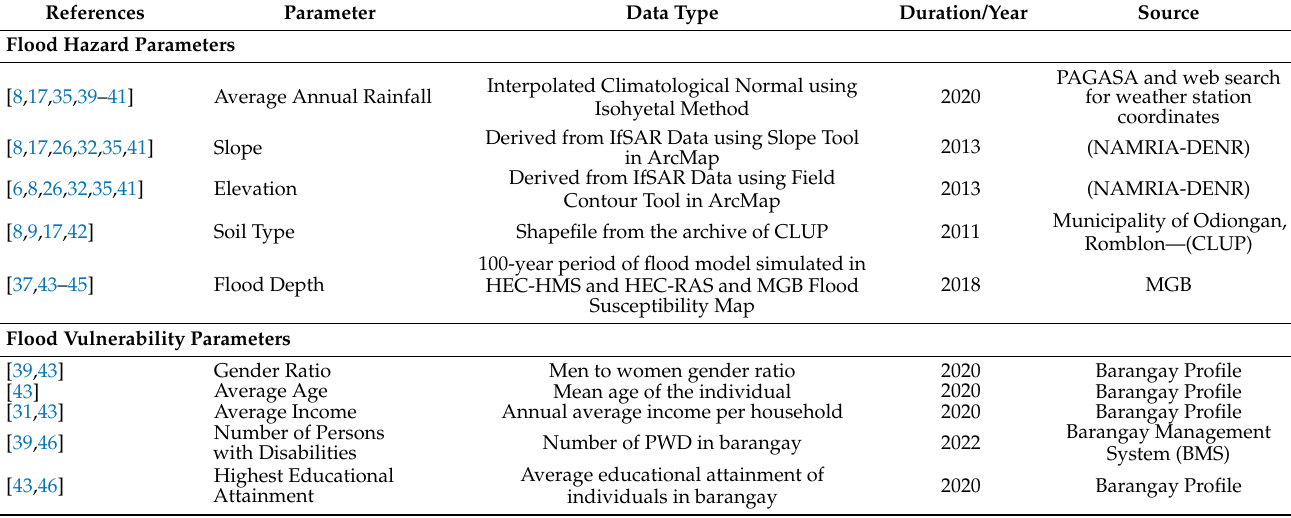
Table 1. Parameters with the type of data used, duration/year, and source used for hazard, vulnera- bility, and exposure assessment.